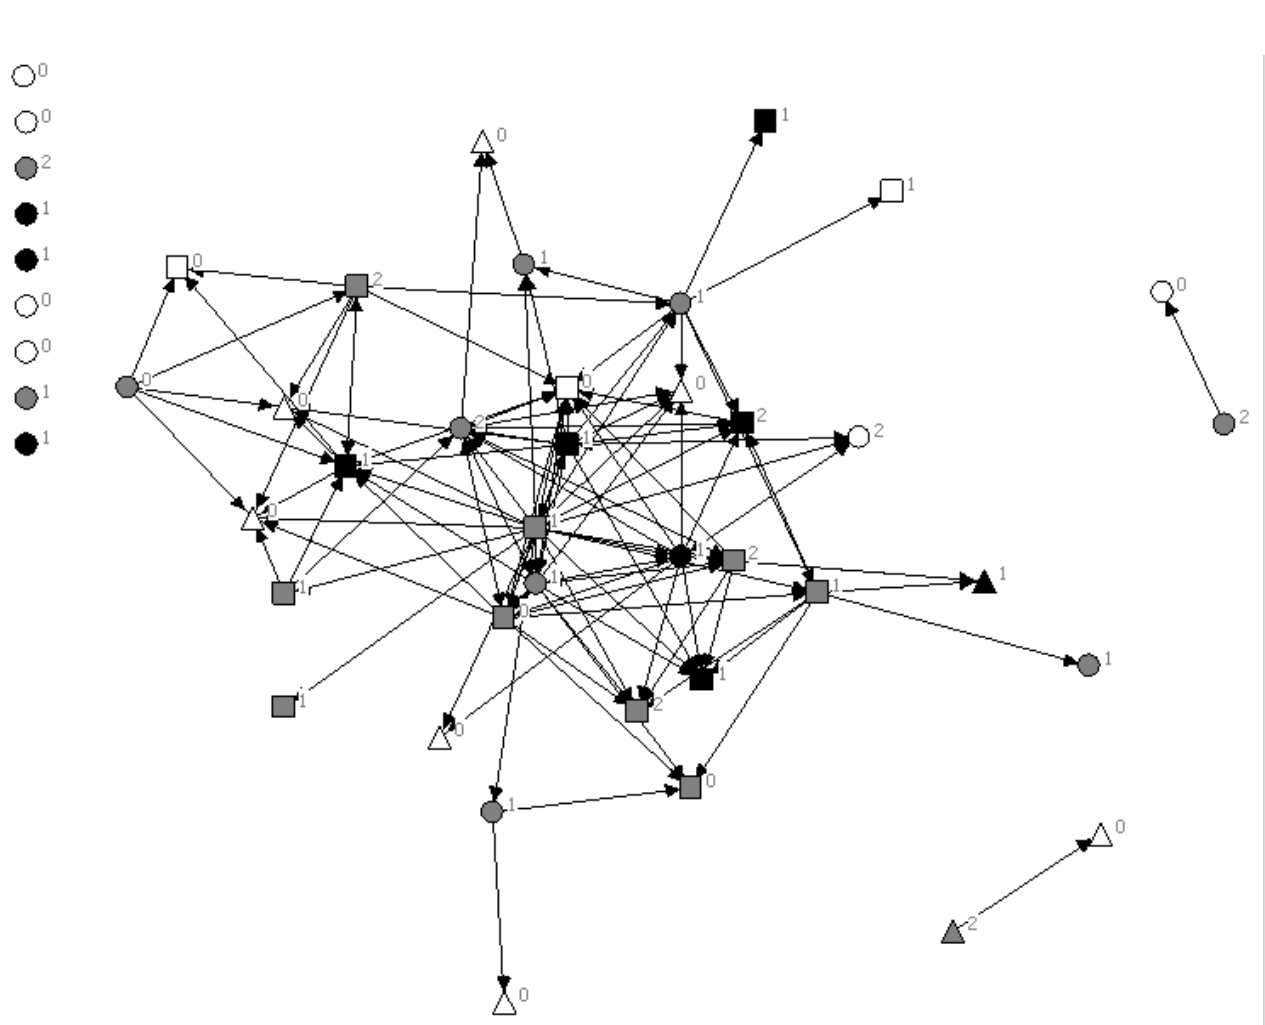
Fig. 4 . Map of network connections indicated by